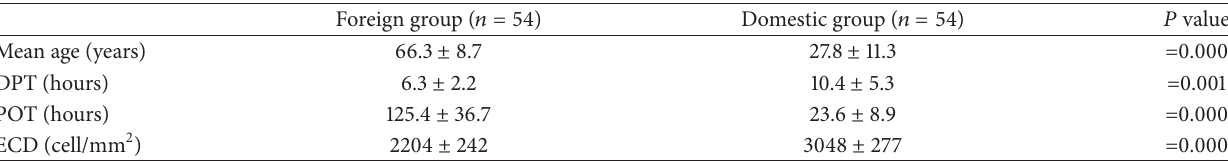
Table 2: Donor-related factors.